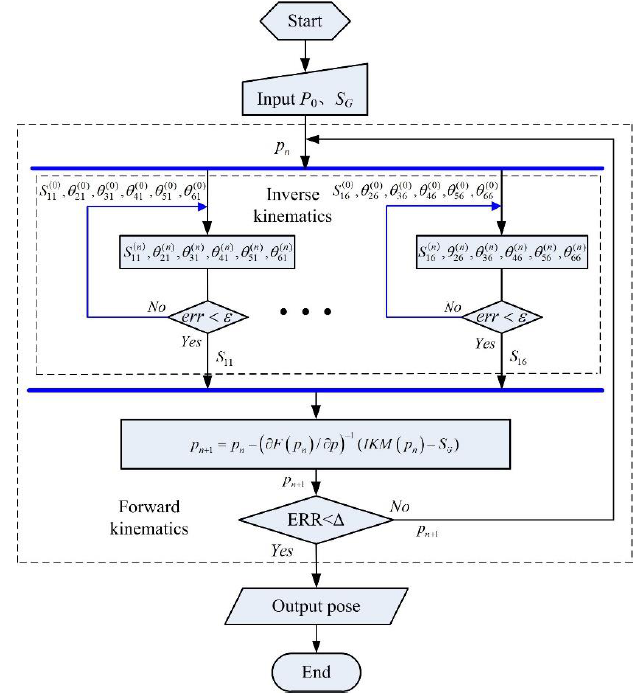
Figure 9. Solution procedure for the forward kinematics.